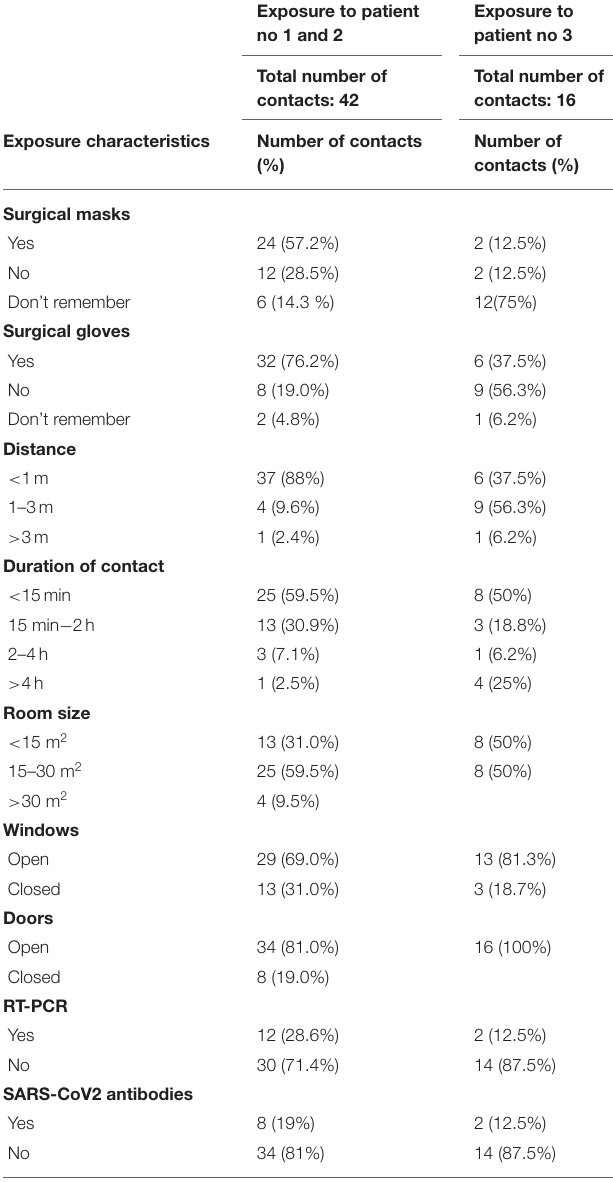
TABLE 2 | Exposure characteristics of hospital staff ( N = 58) who came into contact with three patients with SARS-CoV-2 (patients 1 and 2 with severe, and patient 3 with mild